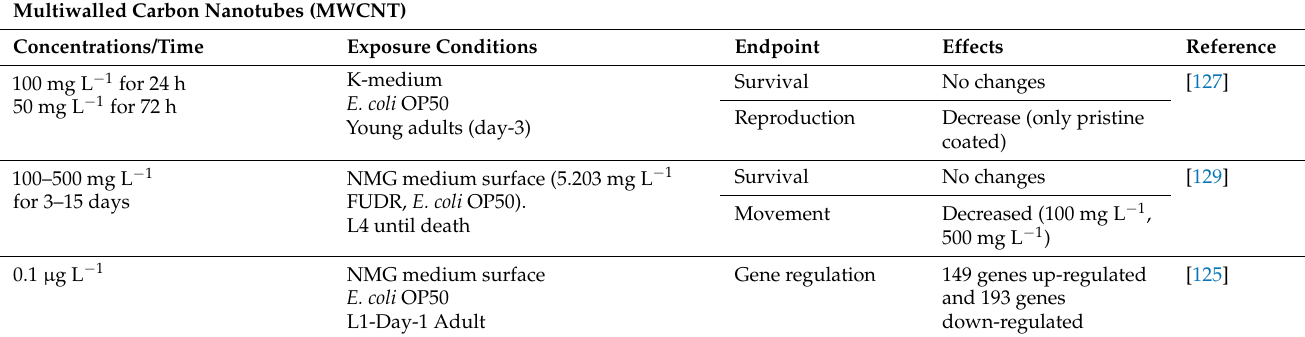
Table 3. Impacts under different carbon nanosystems exposition in Caenorhabditis elegans